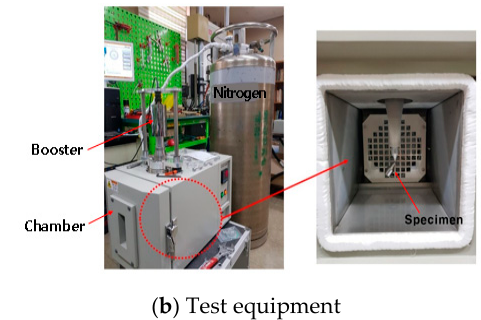
Figure 4. Ultrasonic resonant fatigue test equipment.